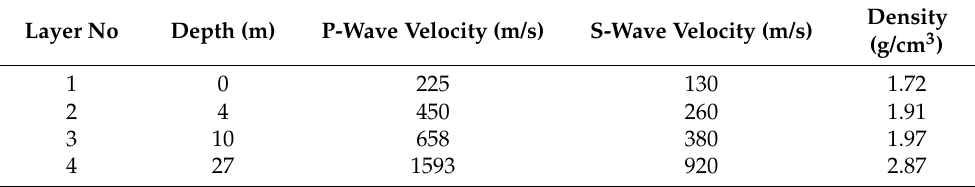
Figure 2. Dispersion spectrograms calculated by different methods. ( a ) Dispersion spectrum calcu- lated by the spatial autocorrelation (SPAC) method. ( b ) Dispersion spectrum calculated by the fre- quency-Bessel method. 3. Application to Field Data 3.1. Geological Background The geotectonic structure of Wuhan City straddles two major primary tectonic units: the Yangtze landmass and the Qinling-Dabie orogenic belt. It is bounded by the Xiangfan- Guangji Fault, the southern side is the southeastern Eurasian Fold Belt of the lower Yang- zte landmass, and the northern side is the Qinling arc-basin system of the Qinling-Dabie orogenic belt. Wuhan is dominated by a denudation landform and an alluvial lacustrine plain landform, the surface is widely distributed within a Quaternary loose accumulation layer, and the underlying bedrock is dominated by four sets of carbonate rocks. The karst area in Wuhan is mainly distributed in strips in the Daye stratigraphic com- munity of the lower Yangzte stratigraphic division in the southern Yangzte stratigraphic region, with hidden karst as the main form. The karst forms are mainly karst gaps, karst pores, and small-scale karst caves, with filling karst caves as the main form. The main soluble rocks are dolomitic limestone and limestone intercalated with do- lomite of the Jialing River Formation in the middle and lower Triassic, and limestone of Daye Formation in the lower Triassic. Meanwhile, there is also chert nodule limestone of the Qixia Formation in the lower Permian, thick layered dolomite and limestone of the